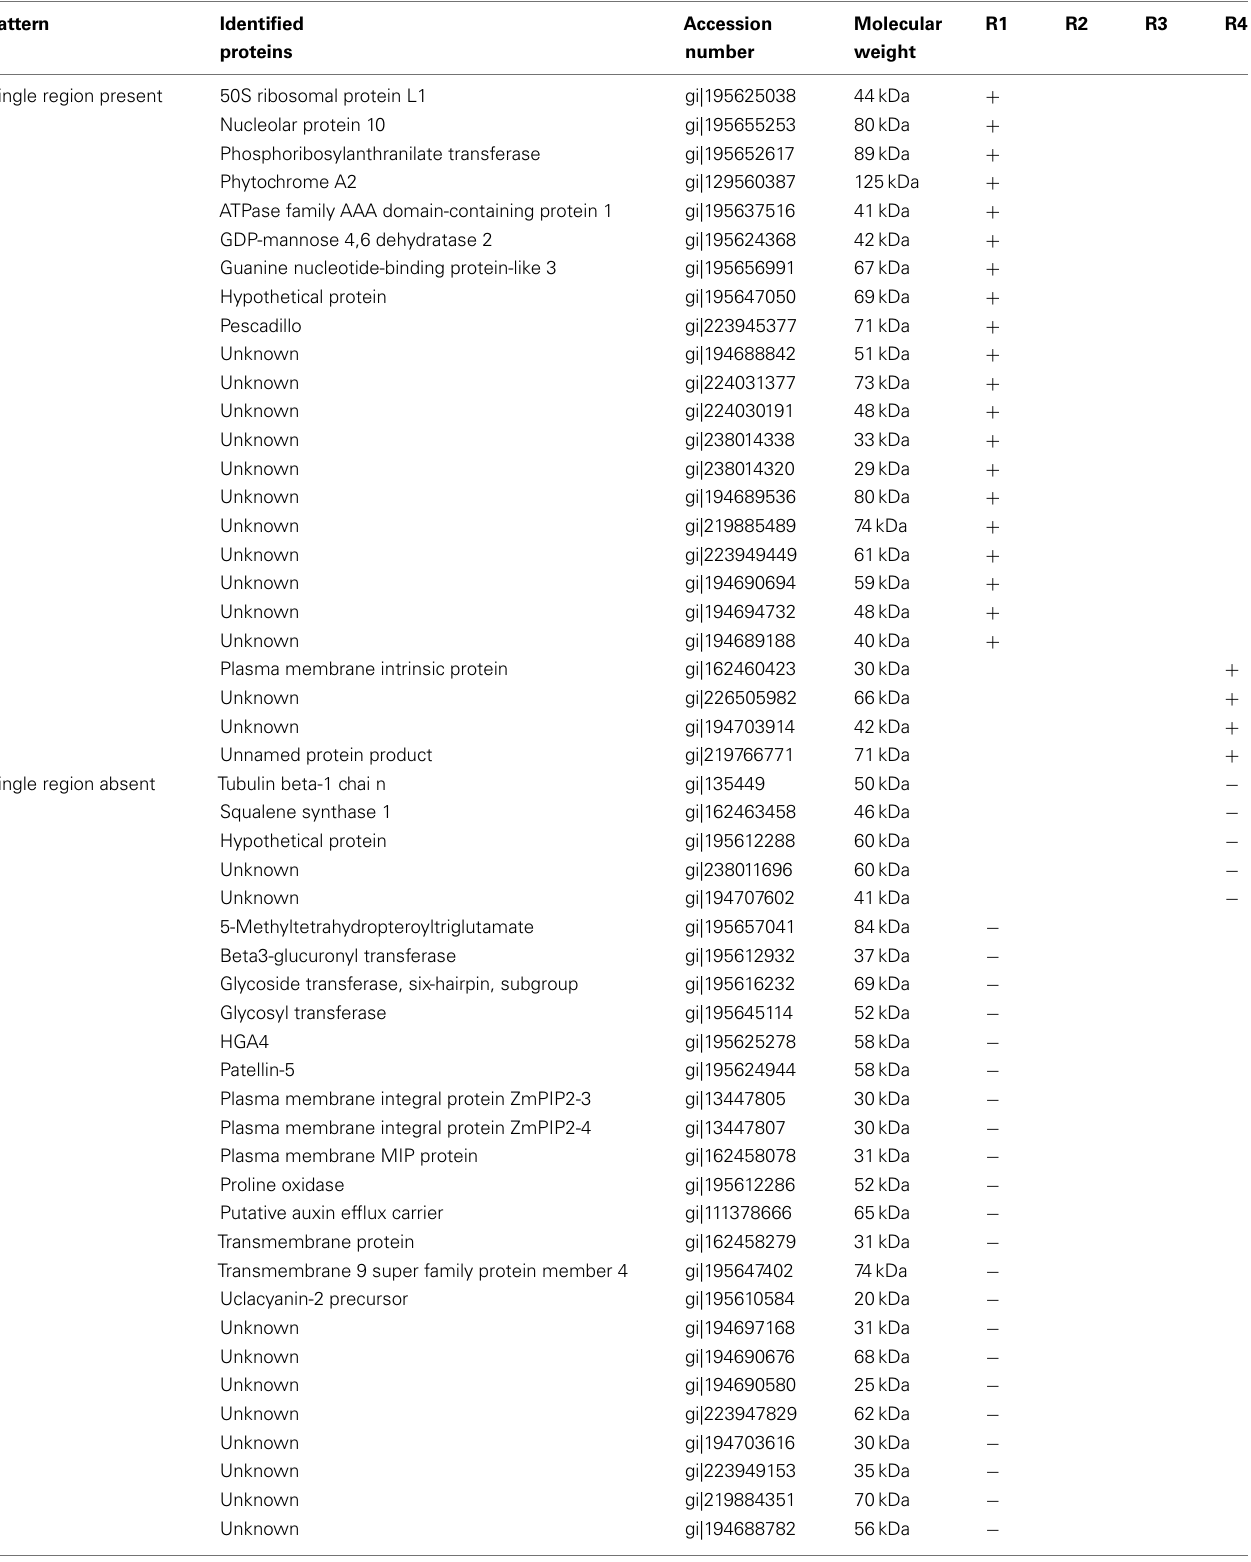
Table 2 | Proteins only present in specific regions in the primary root growth